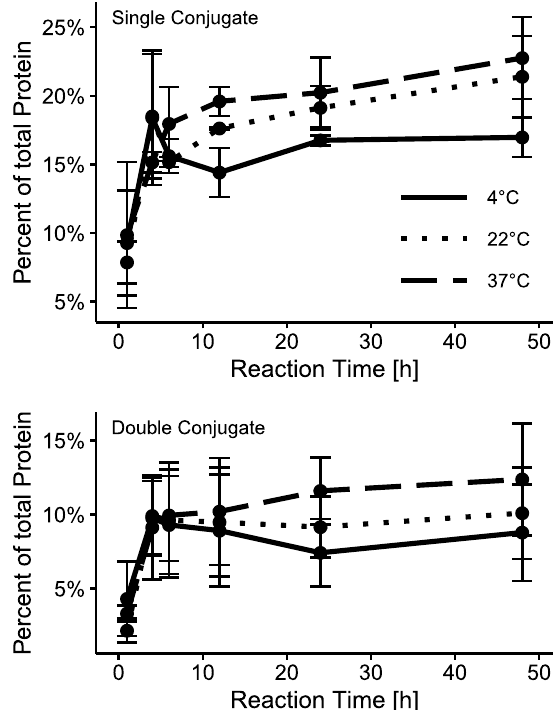
Figure 3. Temperature dependence of the oligonucleotide/antibody click conjugation kinetic. ( A , B ) Click reaction kinetics for the single and double oligonucleotide conjugation products over the course of 48 h for 4, 22, and 37 °C, respectively. Antibody yields were calculated from the chromatograms of IEX